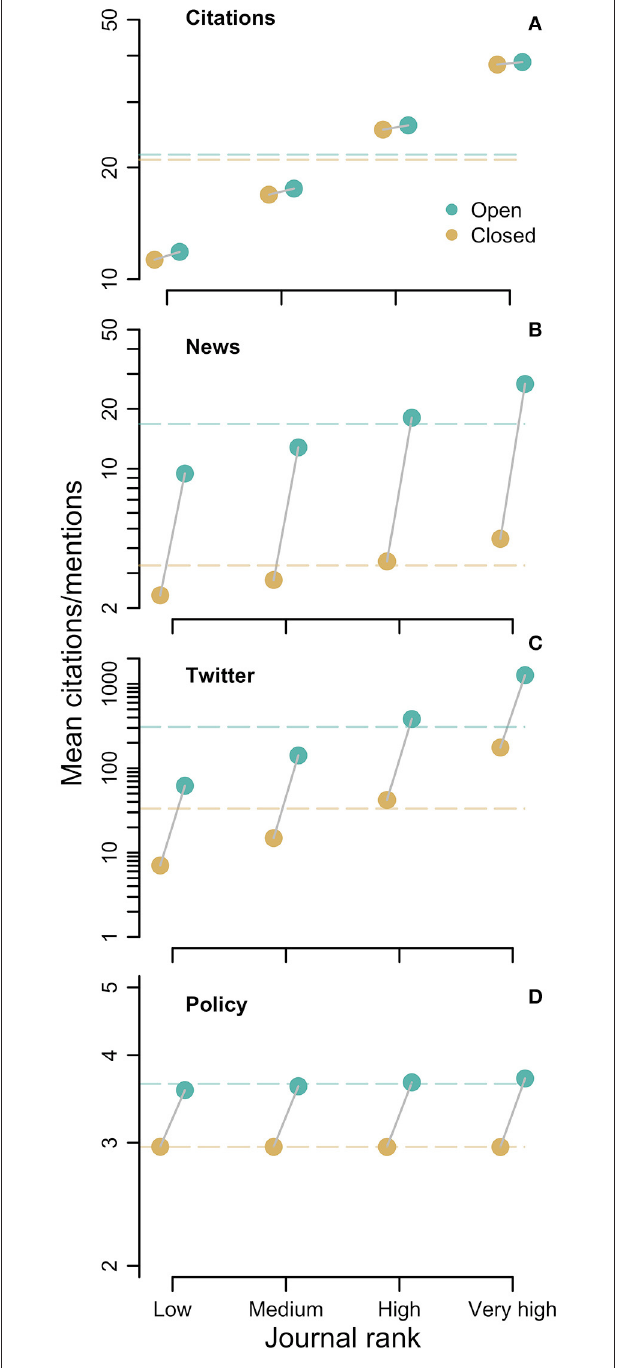
FIGURE 2 | Citations, communication, and media influence of closed and open access climate change studies published between 2007 and 2016. Points are predicted mean number of citations (A) , news mentions (B) , twitter mentions (C) , and policy mentions (D) in four journal ranking categories, controlling for effects of publication year and journal on citations/mentions. Dashed lines are mean citations/mentions controlling for journal rank, publication year and journal name. Citations were extracted from Scopus for the same studies in Figure 1 . News, twitter and policy mentions were